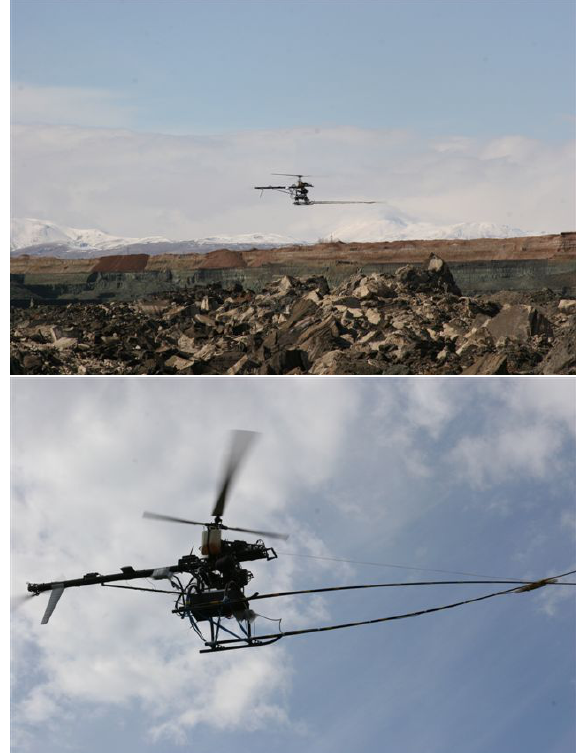
Figure 9: Applied automatic mission flight for aerial magnetic sensing at the coal mining site mentioned